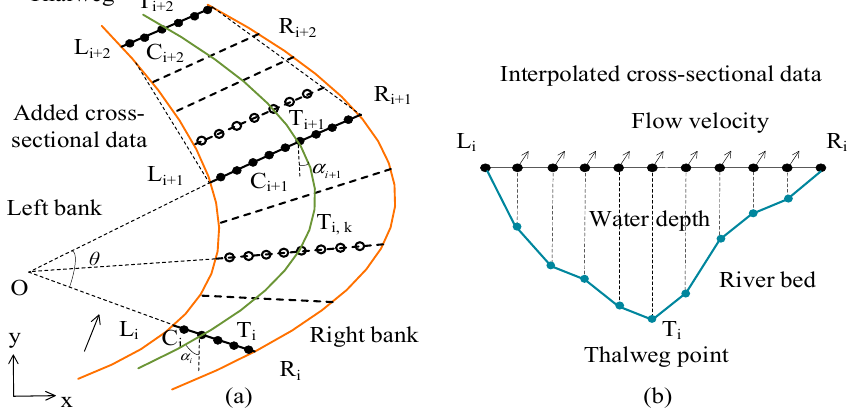
Figure 4. Cross-sectional interpolation: ( a ) position calculation; ( b ) value calculation (flow velocity and water depth).